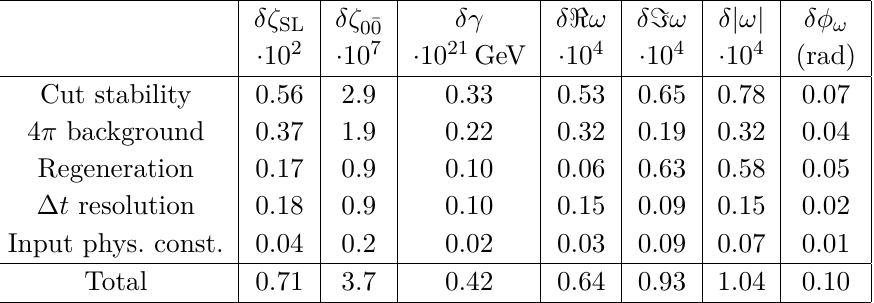
, ζ , and γ they 0¯0 SL